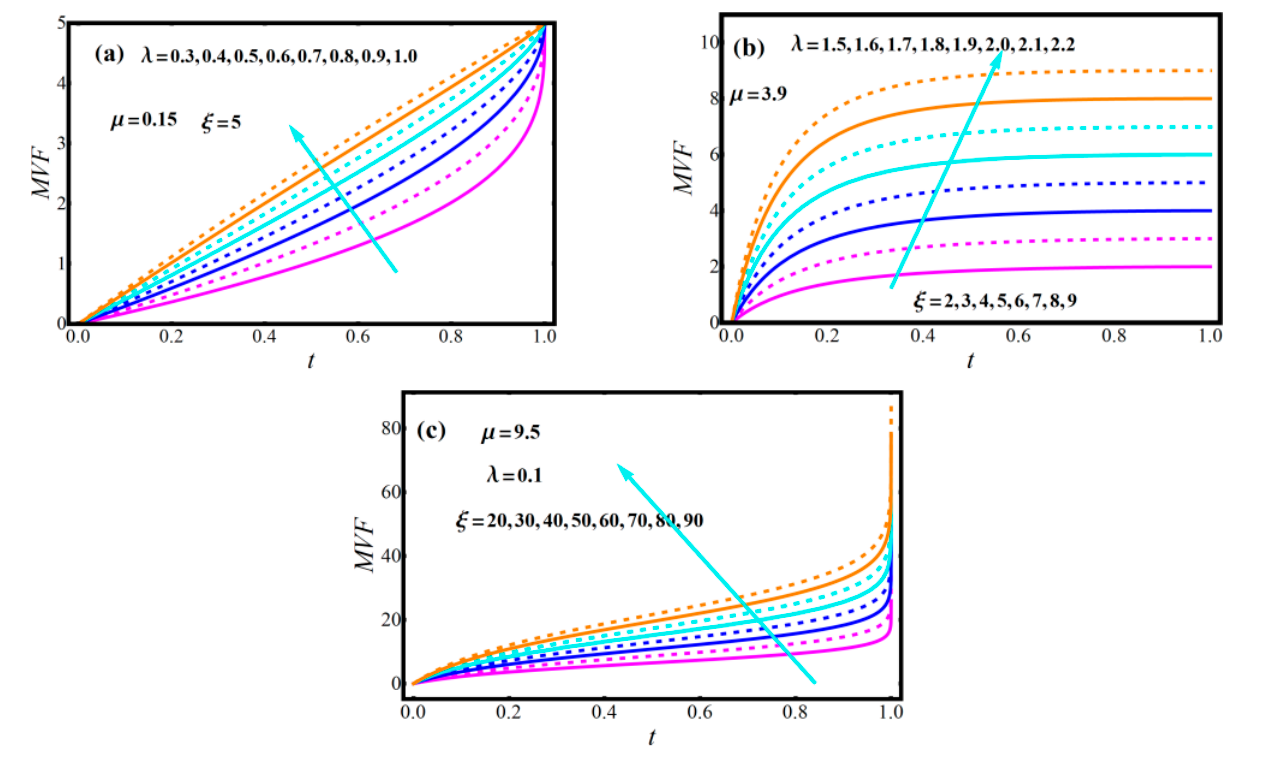
Figure 1. Visualization of the MVF of the NHPP–NPF model.